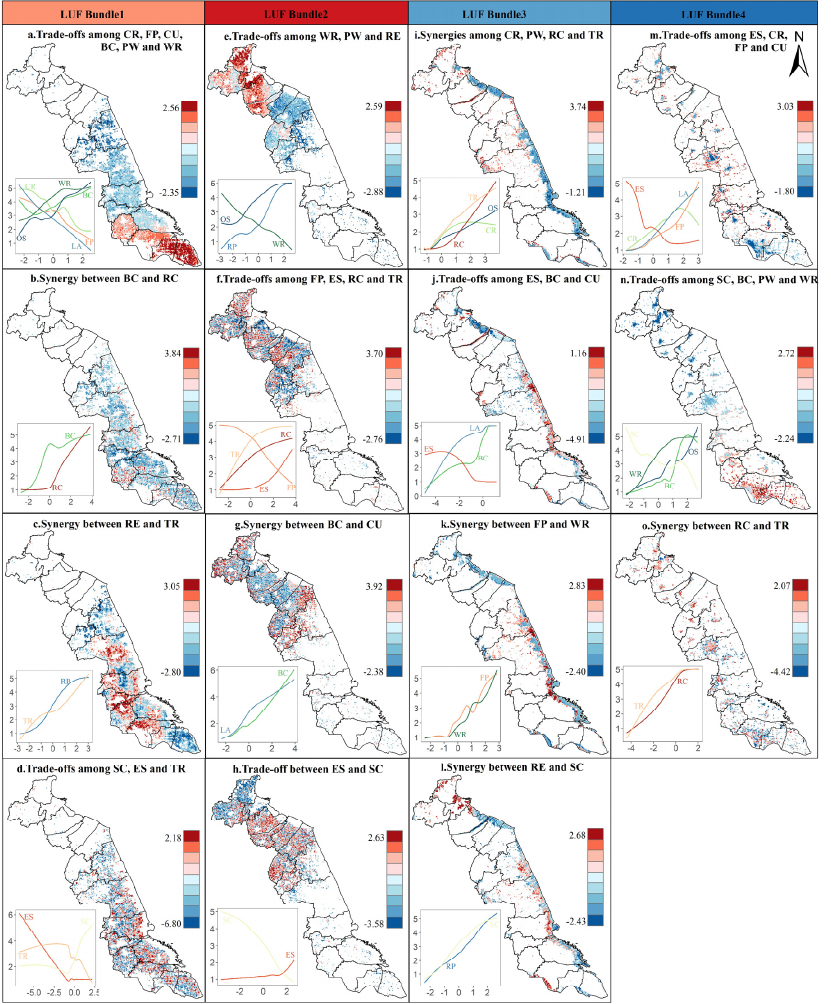
Figure 5. Spatial variations in factor scores of trade-offs and synergies among multiple provided functions in four bundles (2018). The subgraphs are specific combinations of trade-offs and synergies that belong to different LUFBs (LUFB1: a-d; LUFB2: e-h; LUFB3: i-l; LUFB4: m-o). The inset shows the responses of the LUF value (ordinate) to the factor score (abscissa), and the nonlinear curves between them are fitted by GAM. As for the trade-offs among bundled functions, blue areas indicate high values in positive factors and low values in negative factors, while red areas indicate low values in positive factors and high values in negative factors. Regarding the synergies among bundled functions, blue areas indicate that the values of all factors are high, while red areas indicate that all these functions have low values.